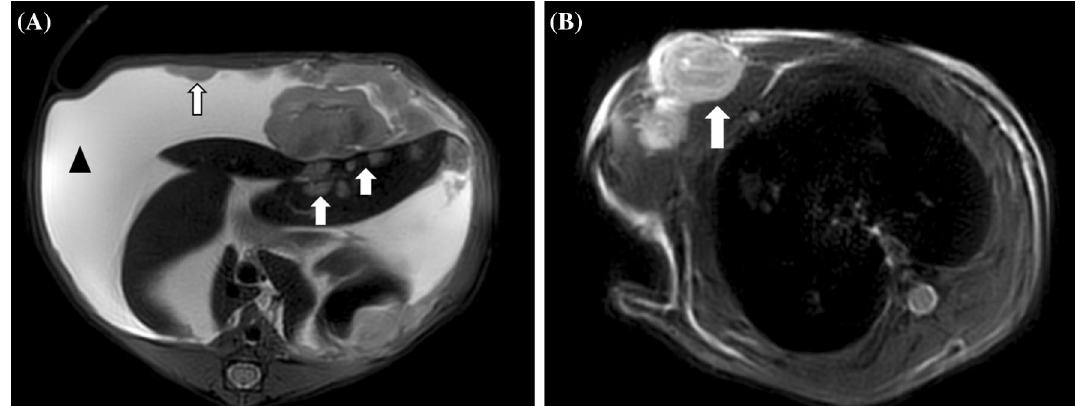
Figure 5. ( A ) In the third week, T2WI image of a rat in LF group showing intrahepatic metastasis (white arrow), ascites (black arrow) and epigastric metastasis (white arrow); ( B ) T2WI image showing chest-wall metastasis (white arrow).